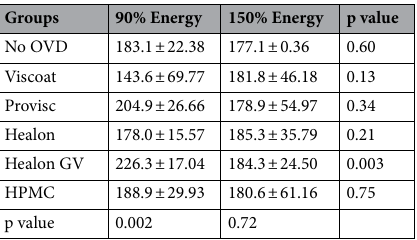
Table 3. Comparison of capsulotomy strength (mN) in different sub-groups with 90% and 150% energy settings.